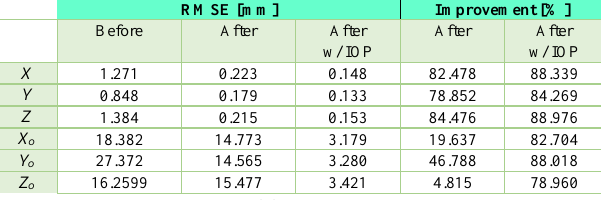
Table 2: In-sample errors of fluoroscopic system 1